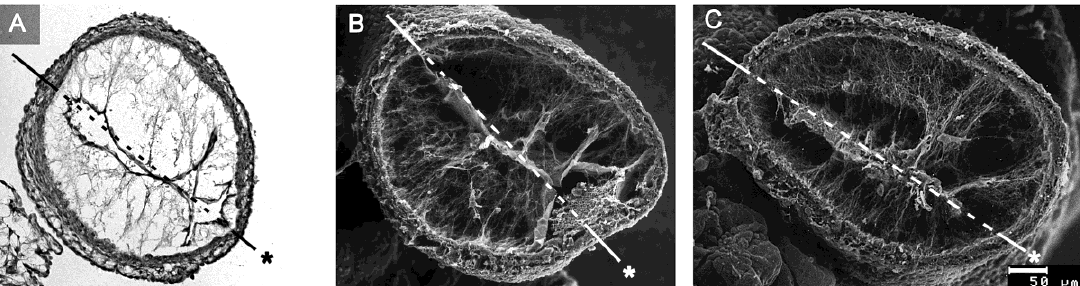
Figure 8. These images depict the architecture of the fibrillar components of the CJ as seen on cross-sections of the ventricular tube of embryonic chick hearts (HH-stage 16). ( A ) Routine histological section (HE staining) at the level of the ventricular bend; and ( B , C ) scanning electron microscopic pictures of cross-sections at the level of the ventricular bend ( B ) and ventricular inflow ( C ). Hearts were fixed at end-systole when the CJ has the greatest thickness during the cardiac cycle. Broken lines mark the closing planes of the collapsed endocardial tubes. Asterisks mark the original ventral midline of the ventricular tube. The CJ fibrils form a delicate network that is anchored to the basal laminae of the primary endocardium and myocardium. Within this network of interconnected fibrils, the principal fiber orientation is perpendicular to the basal surfaces of the endocardial and myocardial tubes. During reopening of the endocardial tube (diastole), the endocardial surfaces curve and the CJ fibrils acquire a principally radial orientation around the center axis of the ventricular tube (not shown).